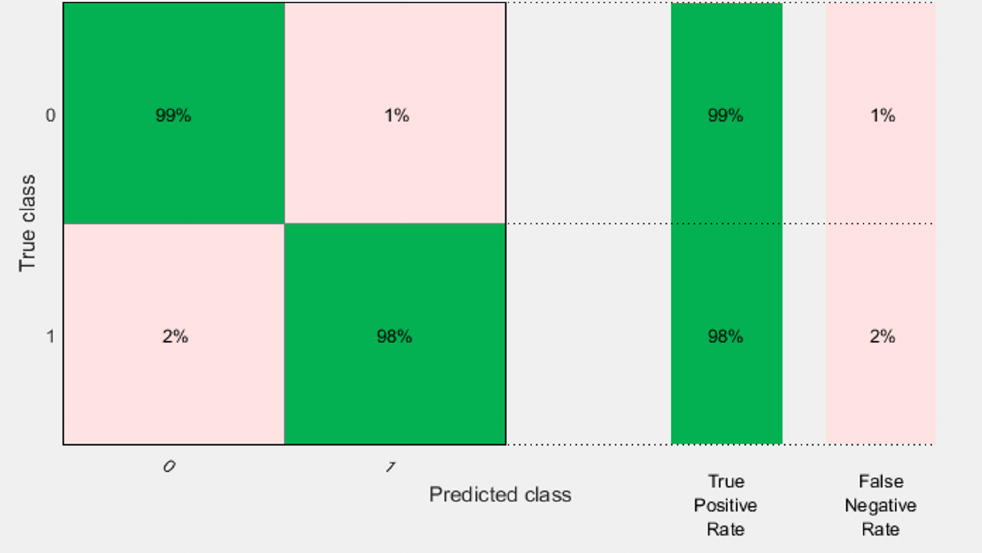
Figure 20. Confusion matrix of ACC and EMG measured from biceps brachii muscle bagged tree